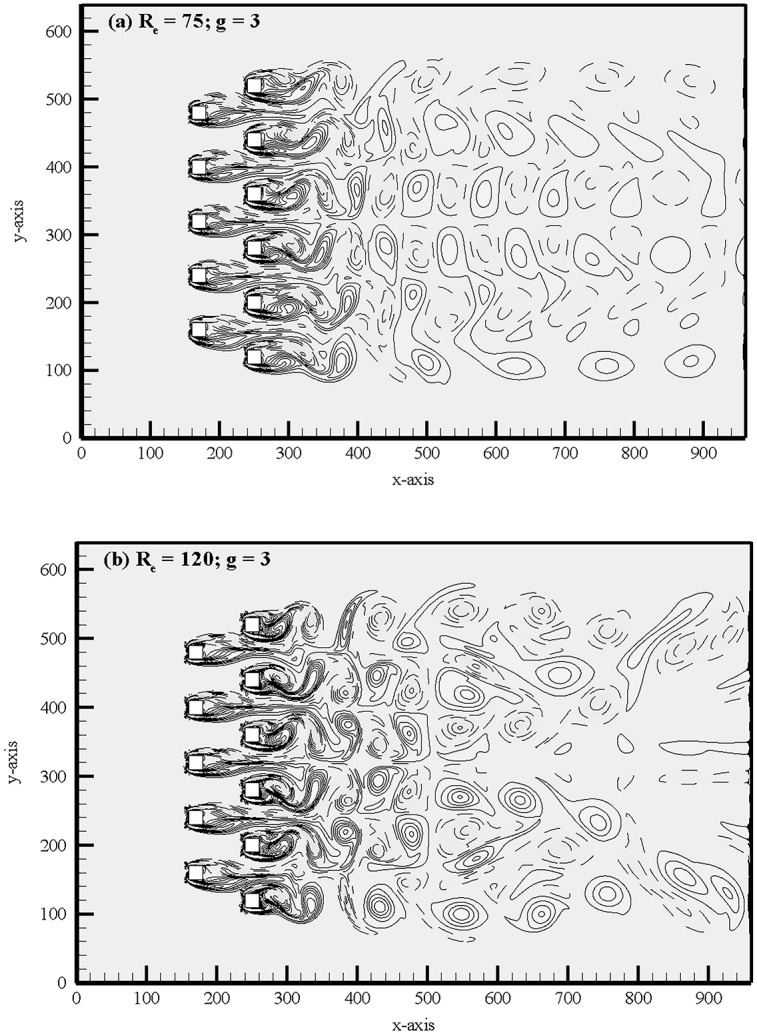
Vorticity contours visualization at (a) (Re, g) = (75, 3) and (b) (Re, g) = (120, 3).